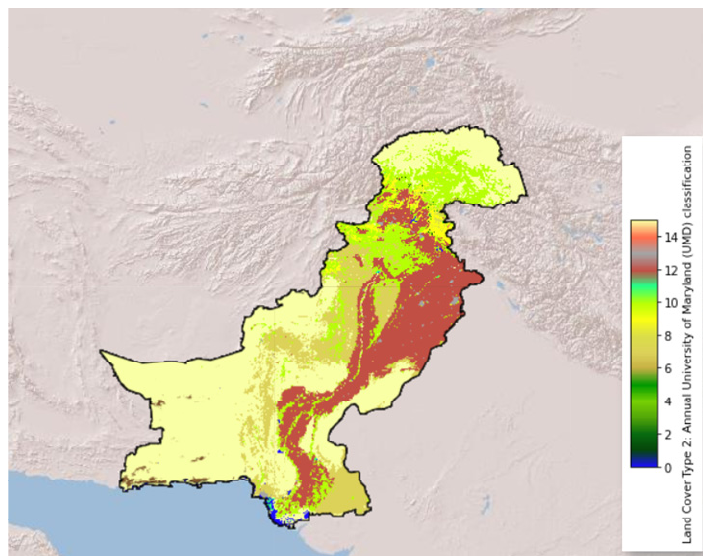
Figure 2. MODIS land cover UMD classification.